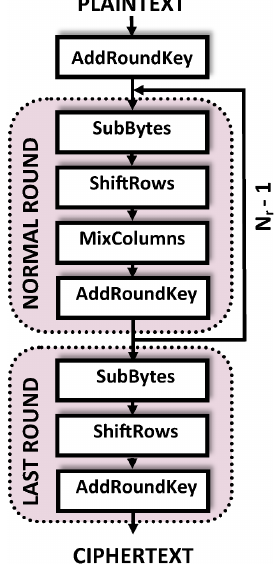
Figure 1. Diagram of the AES encryption